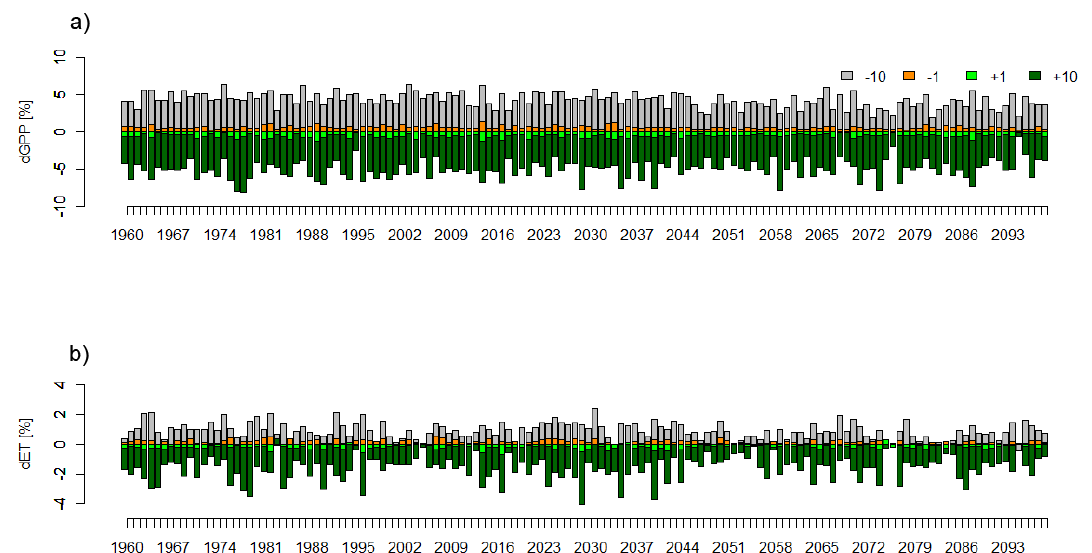
Fig. 10. Barplot of the percentage of variations of annual cumulated GPP (a) and ET (b) simulated with the runs BEPS − 10 , BEPS − 1 , BEPS + 1 and BEPS + 10 (Table 4) with respect to the Reference Run.